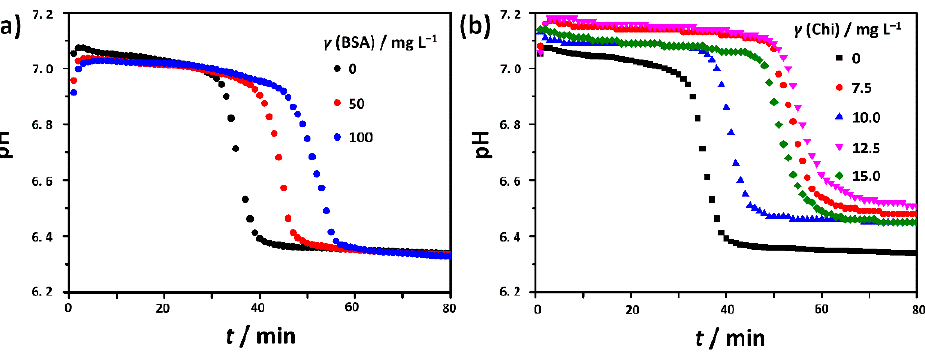
Figure 1. Representative pH vs. time curves obtained in the control system (CS) and in the presence of different concentrations of ( a ) bovine serum albumin (BSA) and ( b ) chitosan (Chi). c (CaCl 2 ) = c (Na 2 HPO 4 ) = 4 × 10 − 3 mol dm − 3 , pH init = 7.4, ϑ = (25 ± 0.1) °C.